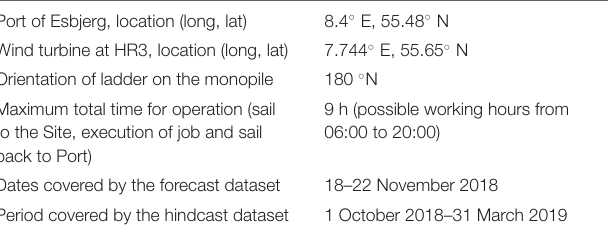
TABLE 1 | Input used in the simulation for Port and Site location and forecast service.